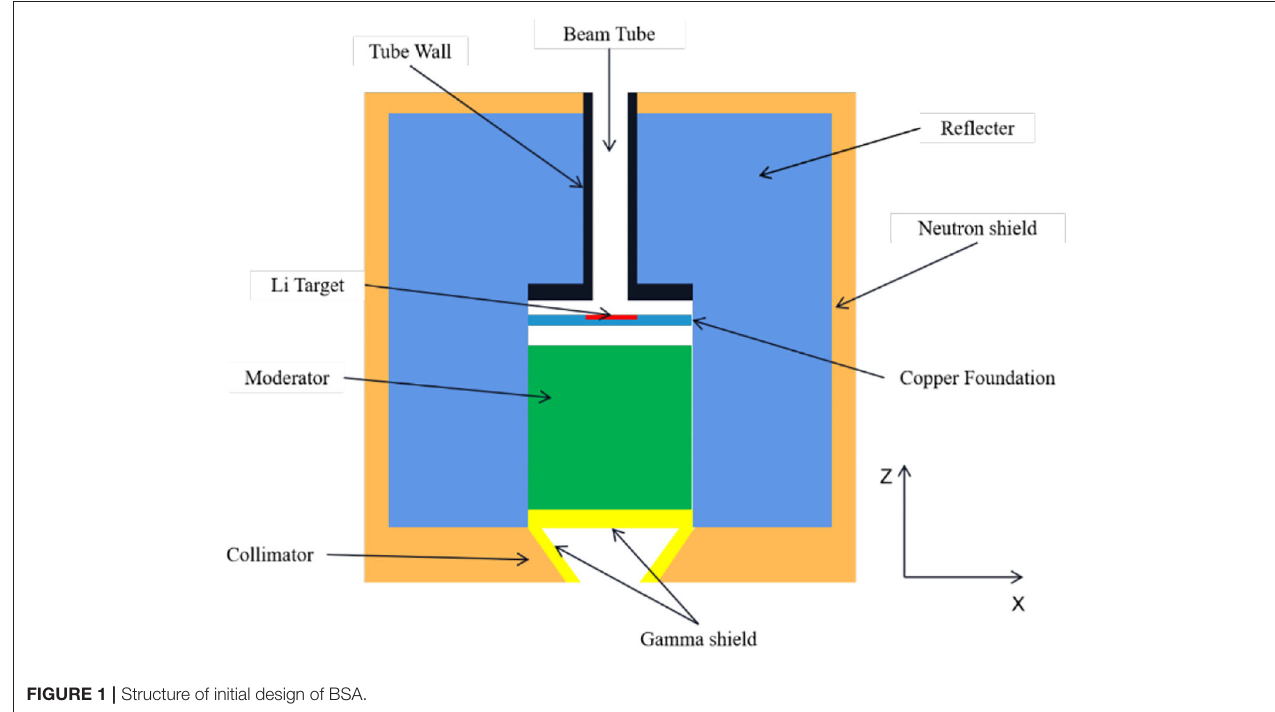
FIGURE 1 | Structure of initial design of BSA.